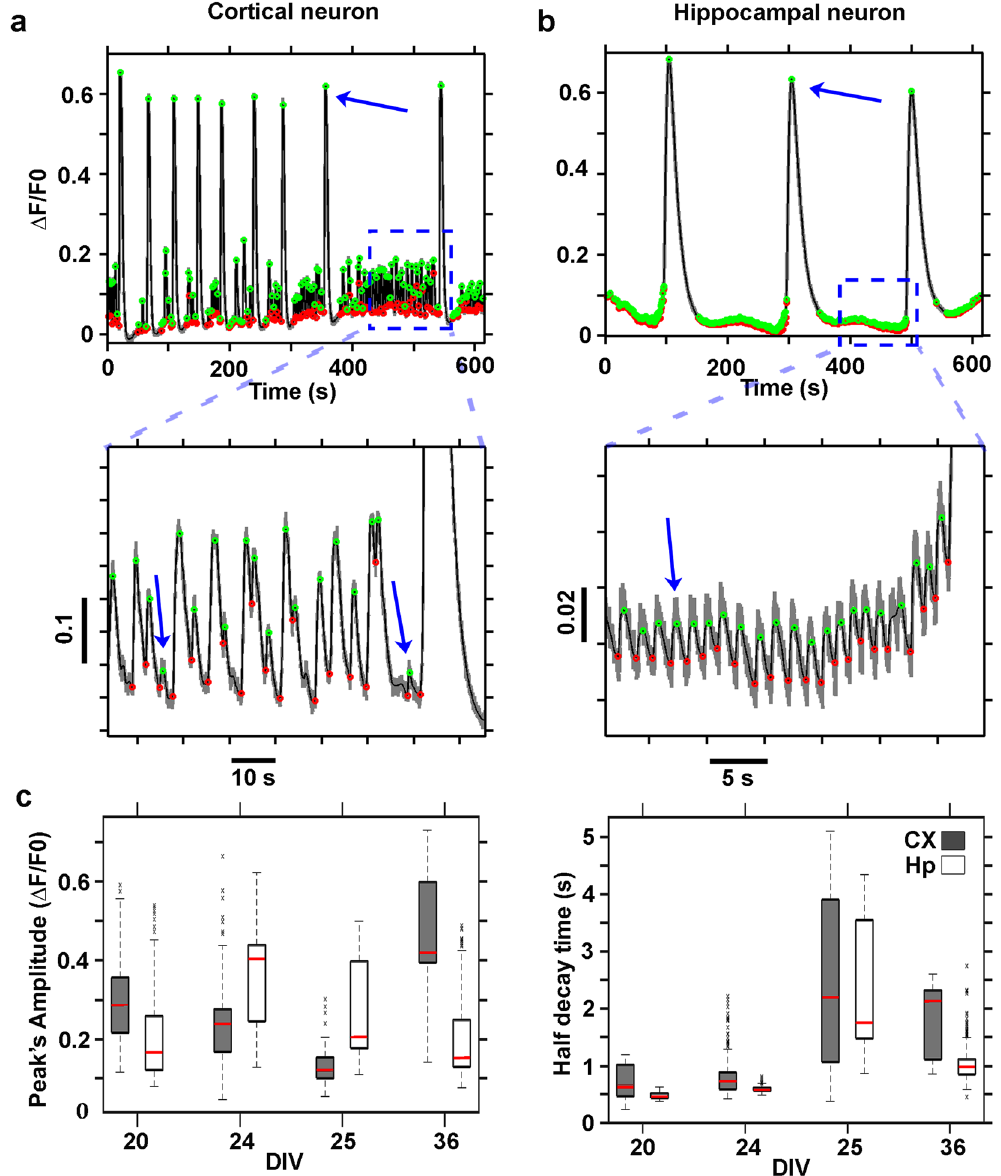
Figure 4. Calcium trace denoising and event detection. Δ F/F0 trace of a cortical neuron of a cortical 3D network at 24 DIVs ( a ) and of a hippocampal neuron of a hippocampal 3D network at 36 DIVs ( b ). The denoised traces are shown in black while the onset and offset of the events are marked, respectively, in green and red. The insets, below the graphs, show the small amplitude events which were detected; In ( c ) Box plots illustrating the distribution, at distinct DIVs, of peak amplitudes (left panel) and the half decay times (right panel) of the detected fluorescence fluctuation events of cortical (CX) and hippocampal neurons (Hp) traces. The value distributions in the box plots have been computed on all the detected traces (691 ÷ 1495 distinct cell traces) of n = 6, 7, 8, 4 cortical and n = 4, 3, 6, 6 hippocampal distinct hydrogels at respectively 20, 24, 25, 36